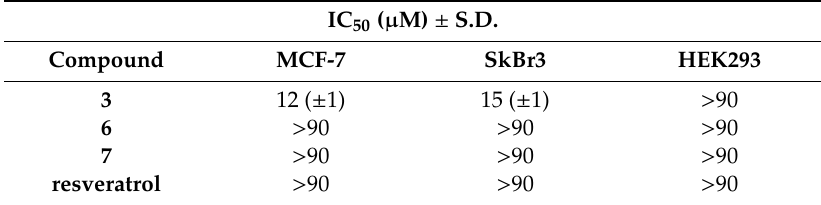
Table 2. Antiproliferative activity of tested compounds on breast MCF-7 and SkBr3, cancer cells and HEK293 cells, after 48 h treatment, as determined by using the MTT assay. IC 50 values were calculated by probit analysis ( p < 0.05, χ 2 test) and are the mean ± SD of three independent experiments performed in triplicate.